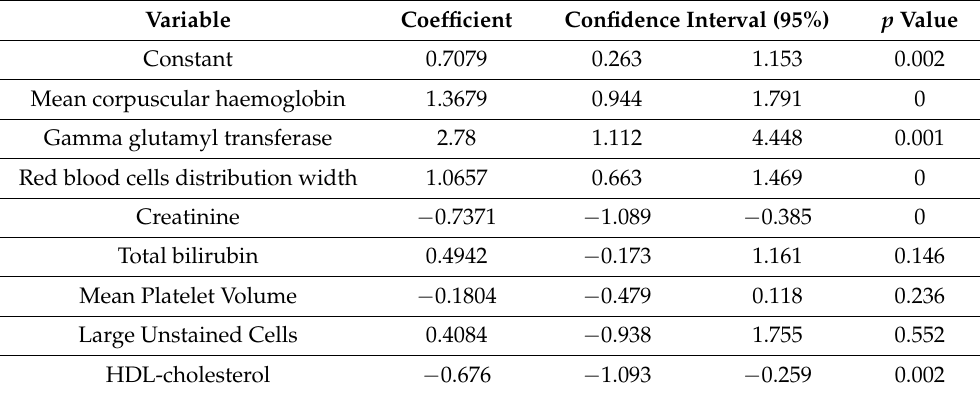
Table 2. Coefficients calculated for logistic regression model for ‘risk’ with automatic selection (IWSSr), for the variables used, together with the confidence interval and its p value.